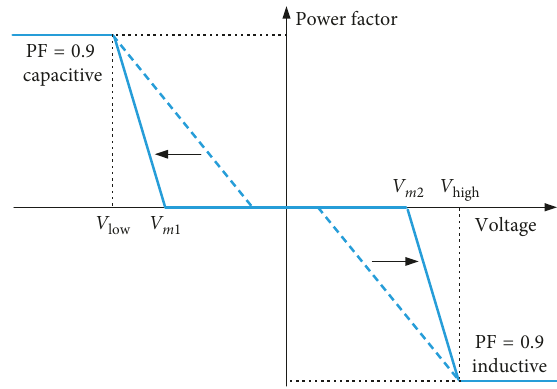
Figure 6: Power factor droop curve with wider dead band. Table 4: Voltage regulation performance with different power factor droop